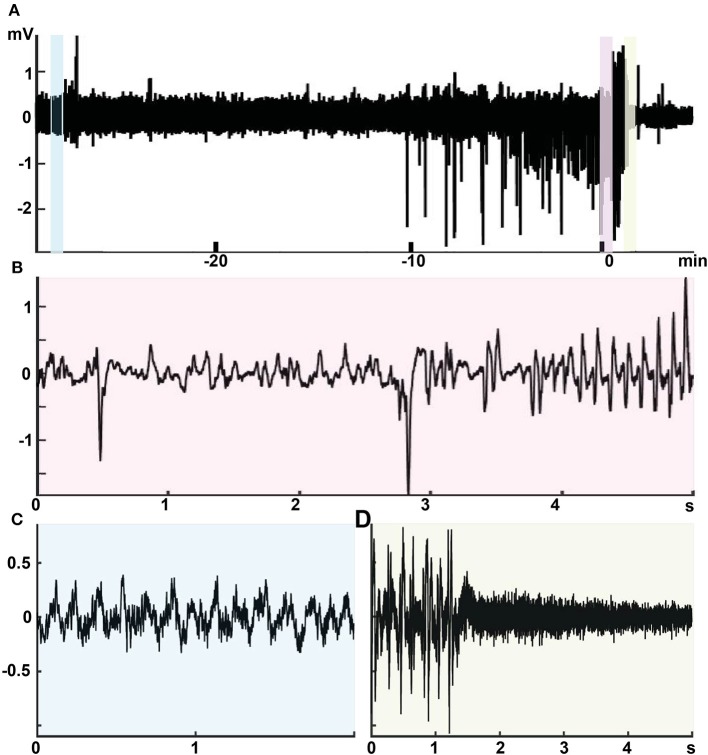
Intimate relationship between giant spikes and a seizure in a 9-month-old male APPswe/PS1dE9 mouse. Recording from one channel of a movable tetrode located in the CA1 pyramidal cell layer. (A) An overview of the recording session at a low time resolution. Time 0 is the seizure onset. During the first 40 min up to time −10 min in the figure, the mouse was in a constant movement and the LFP shows regular theta rhythm with overriding gamma oscillation (inset C, light blue). Then the mouse fell asleep and the LFP shows frequent giants spikes during ~10 min. The last giant spike is continuous with the onset of a 32-s generalized seizure (inset B, pink). The seizure ends with a total suppression of the LFP for ~40 s (inset D, light green).